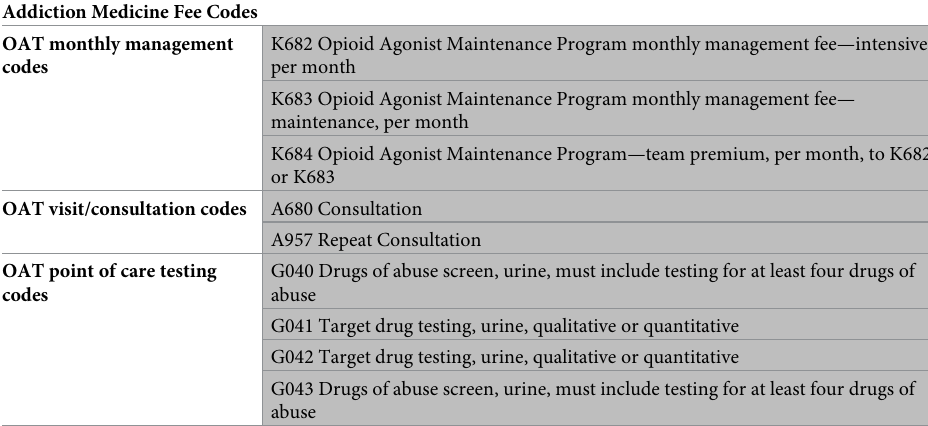
Table 1. Addiction medicine fee